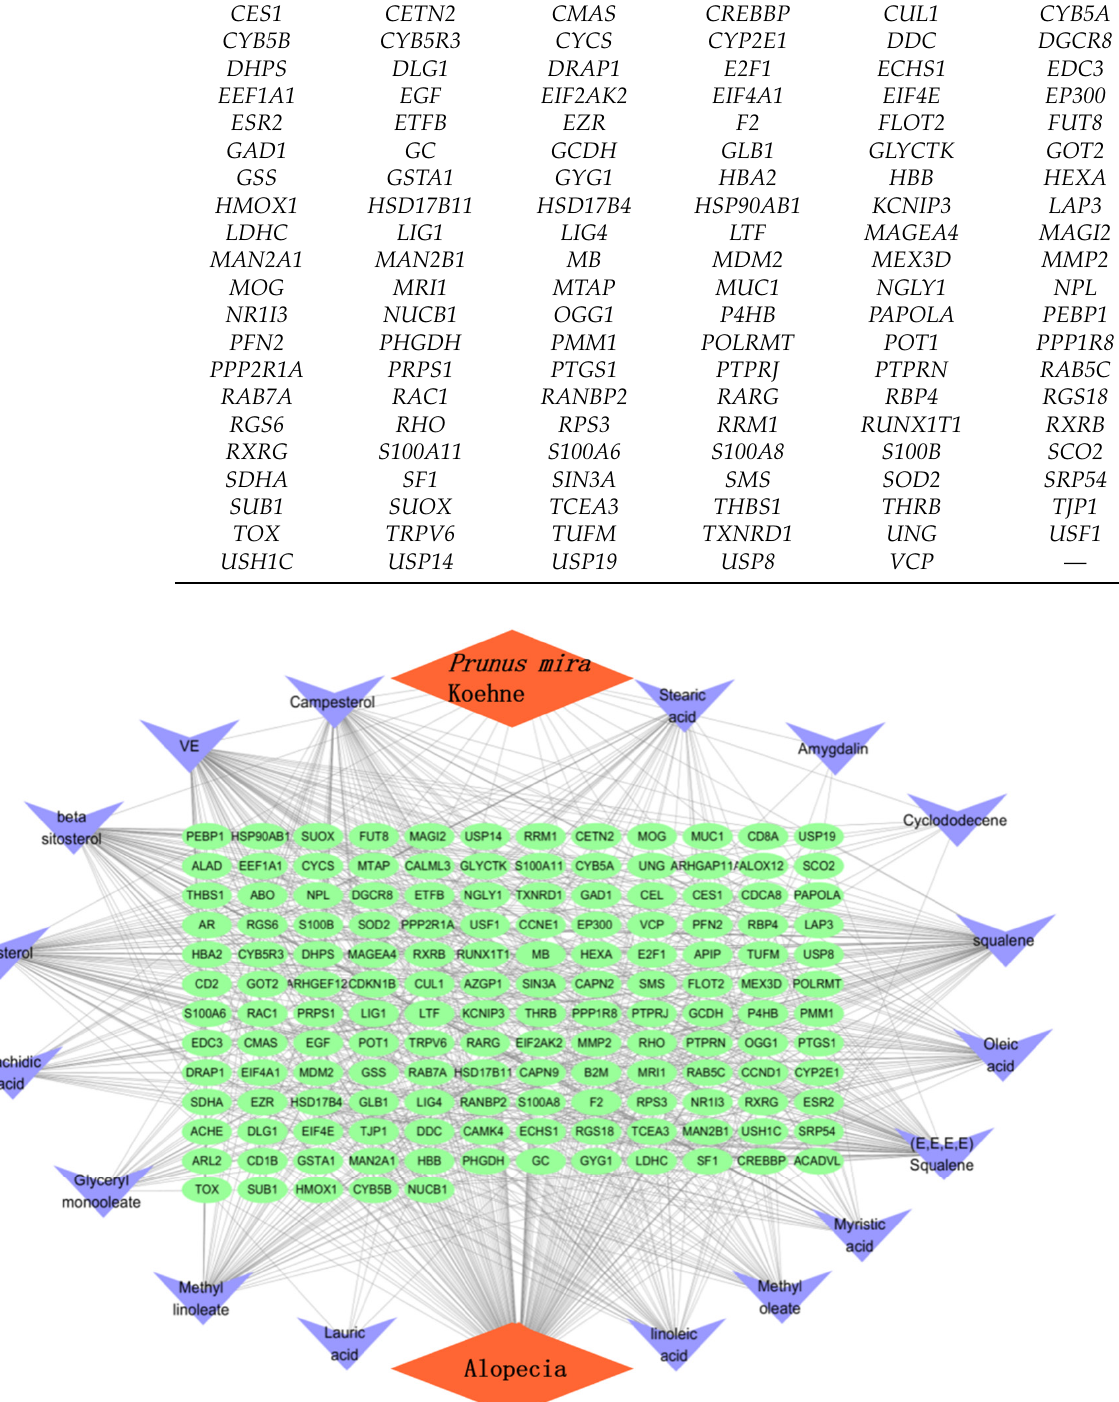
Figure 4. The kernel of P. mira -chemical composition-target-alopecia“ network analysis diagram.